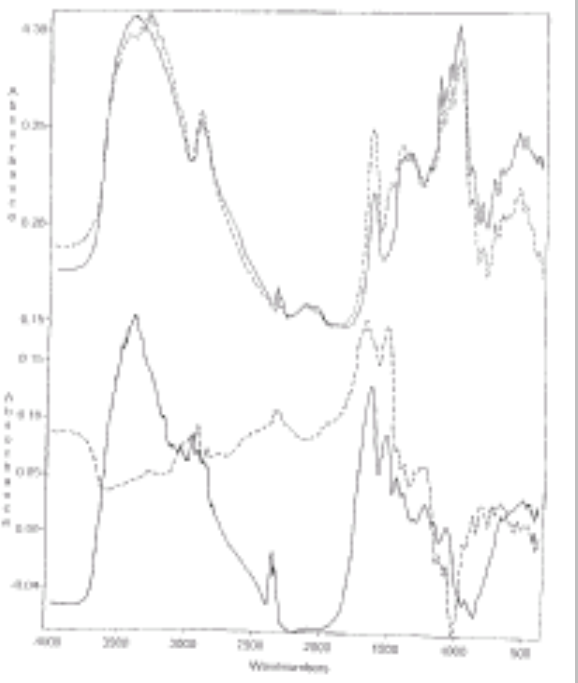
Figure 1. ( 1 ) Differential FTIR spectra of casein/GPWCS 2:1 complex from which (a) the spectrum of GPWCS was subtracted and (b) the spectrum of casein was added for comparison; ( 2 ) Differential FTIR spectrum of the same complex from which (a) the spectrum of casein was subtracted and (b) the spectrum of GPWCS added for